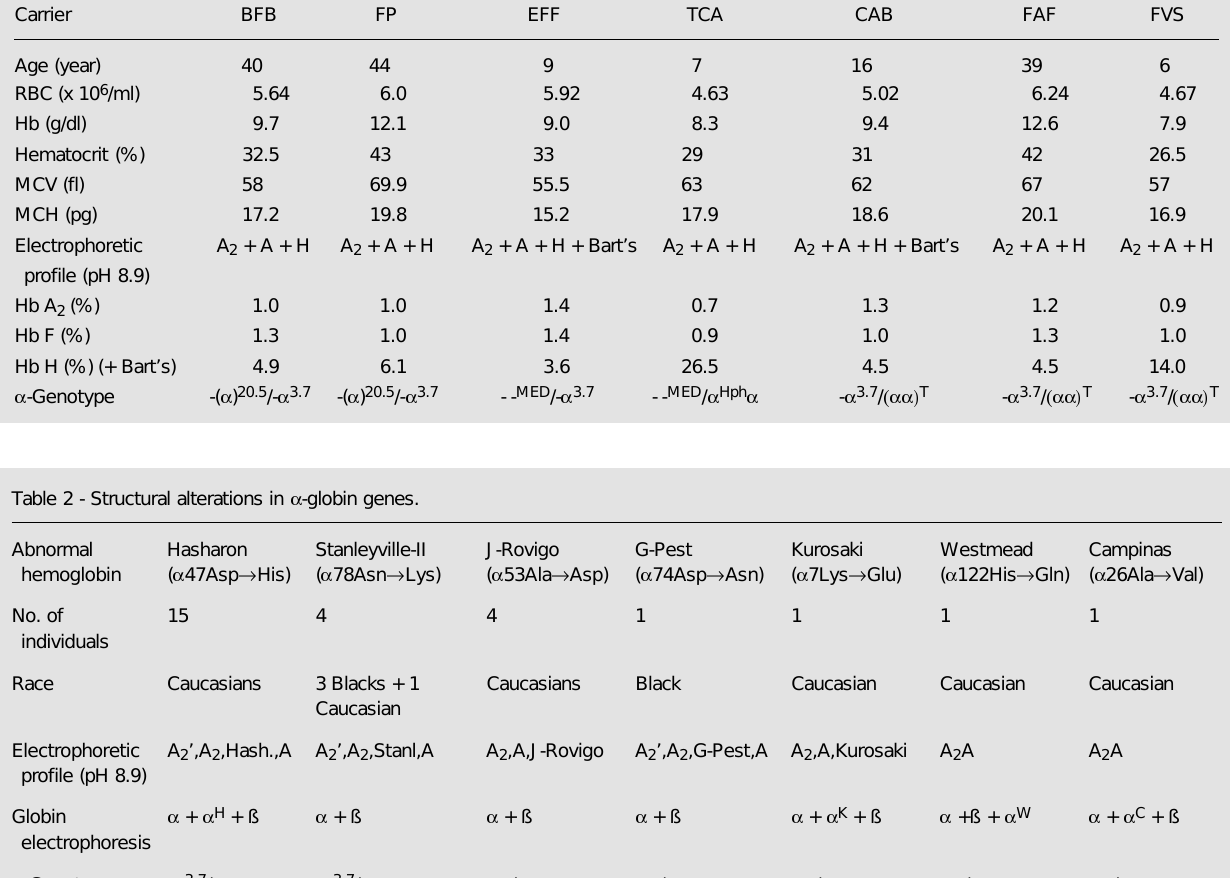
Table 1 - Hematological data for the patients with Hb H disease. RBC, Red blood cells; MCV, mean corpuscular volume; MCH, mean corpuscular hemoglobin. Carrier